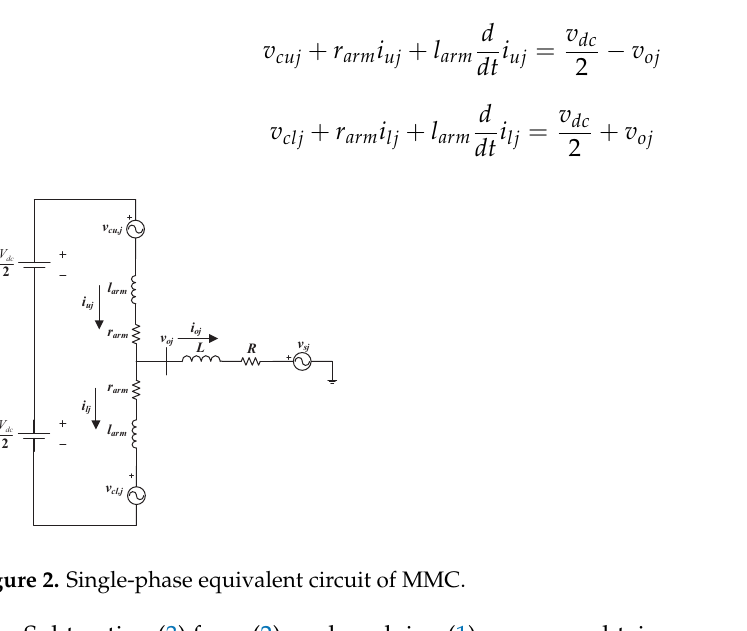
Figure 1. The schematic circuit of MMC. To derive the model of the MMC, one may follow the analysis presented in [11,27], and the single-phase equivalent circuit, as shown in Figure 2 is considered. The voltage sources v cuj and v clj represent the AC voltages produced by SMs. The DC voltage is considered as constant and is denoted by V dc in Figure 2. By applying Kirchhoff’s current law (KCL), the line current can be obtained as where i uj and i lj are the upper and lower arm currents of the single phase of MMC, and j ∈ { a , b , c } . Furthermore, two sets of equations can be written for the AC side via Kirchhoff’s voltage law (KVL), as defined in (2) and (3).